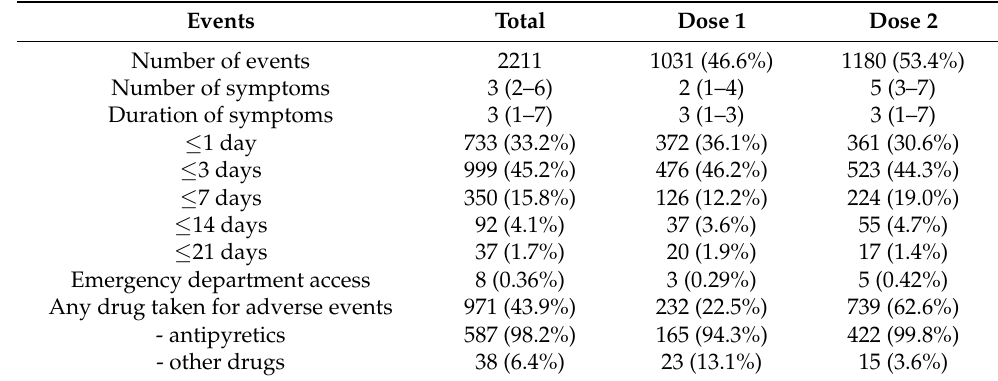
Table 1. Self-reported adverse events following the two doses of vaccine. Continuous variables are expressed as median (IQR).